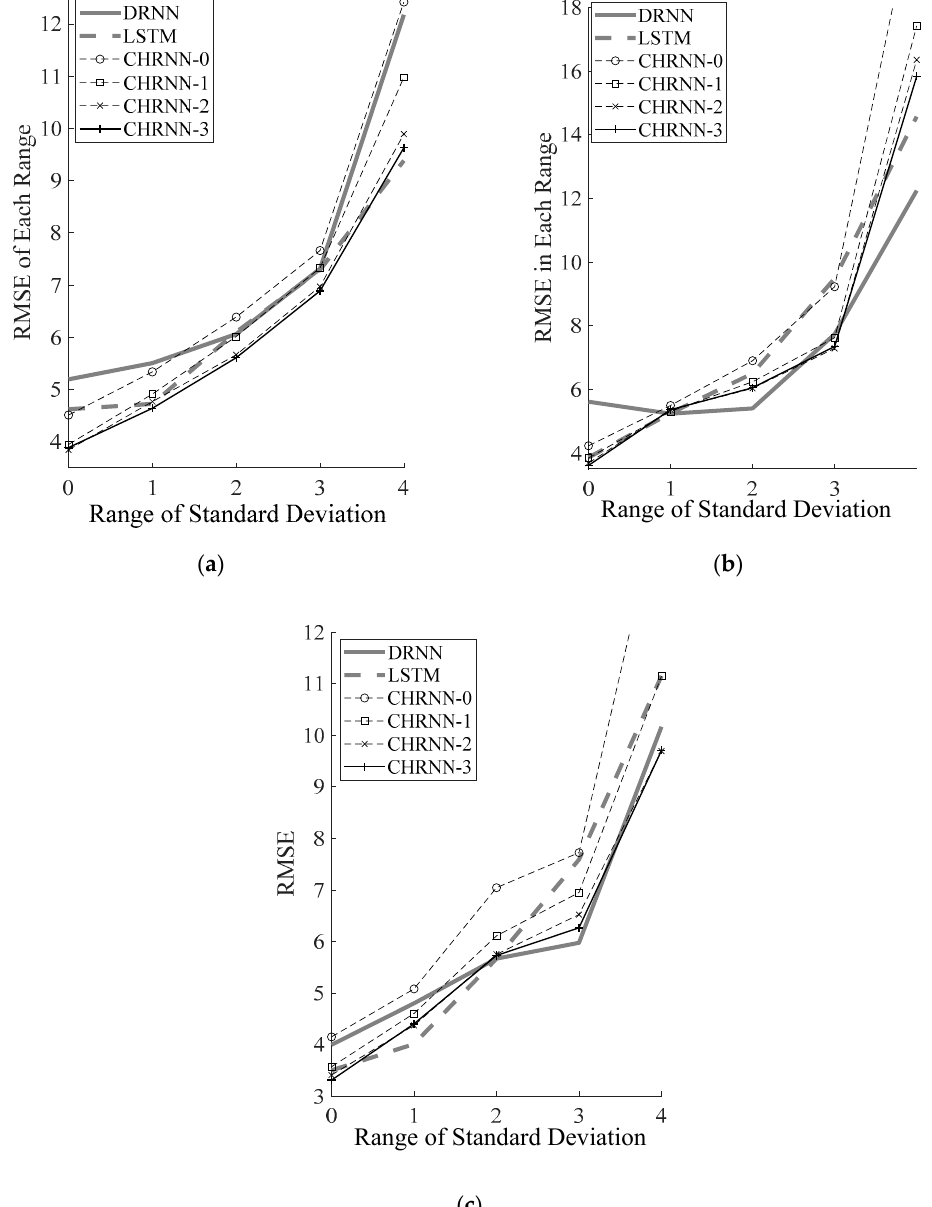
Figure 14. RMSE of different particulate matter 2.5 (PM 2.5) ranges in different models: ( a ) DaLi; ( b ) FengYuan; ( c ) ChungMing.